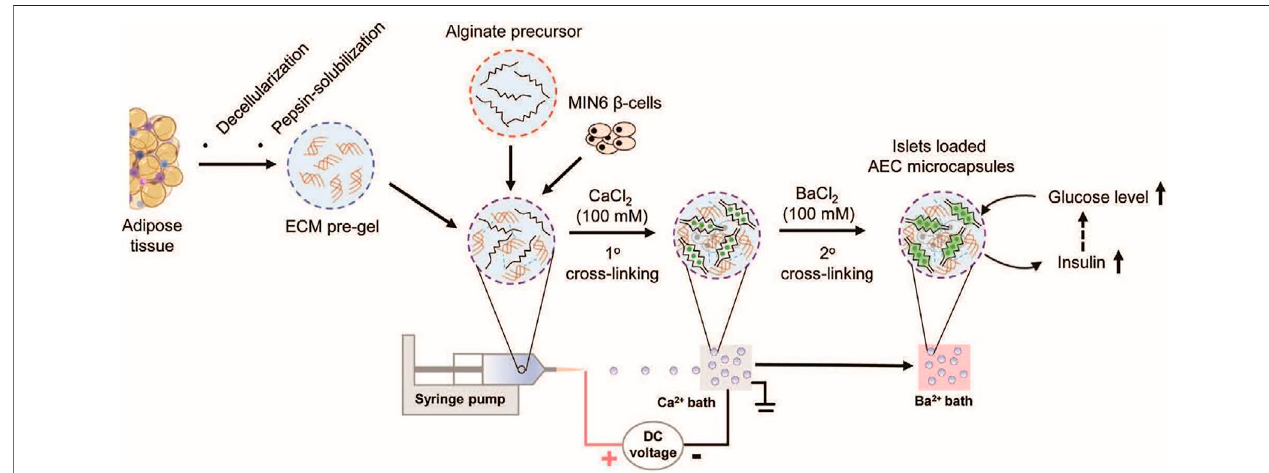
FIGURE 1 | Schematic illustrating fabrication steps alginate microcapsules containing human adipose tissue-derived ECM and microencapsulation of pancreatic islets (J. K. Wang J. K. et al., 2020).